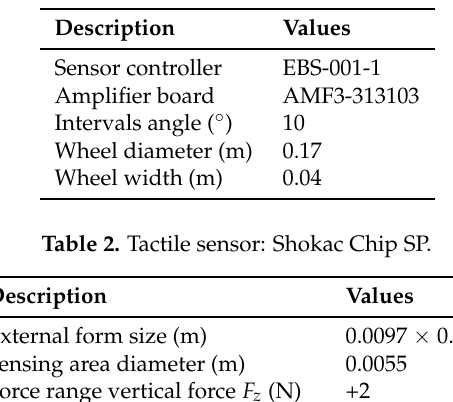
Table 1. Wheel sensor system.